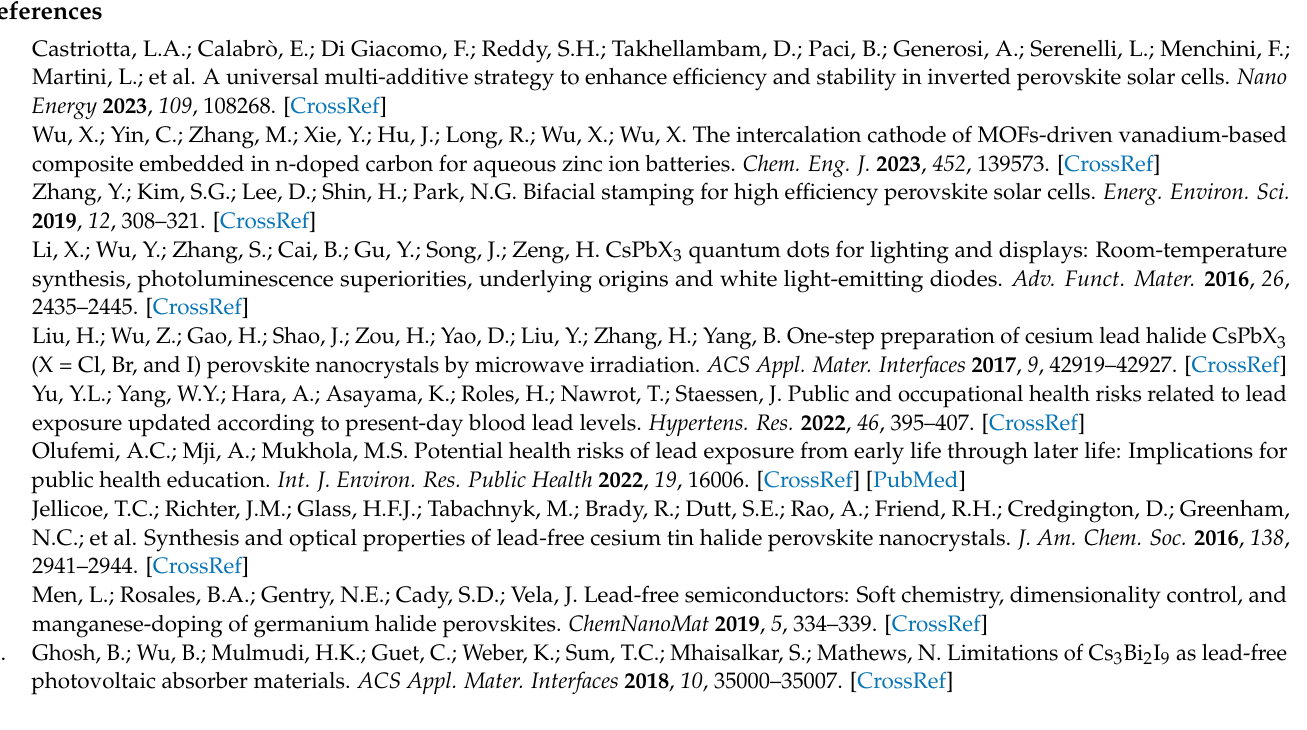
Figure S2: Enlarged shifts of (220) peak of MCs; Figure S3: XPS spectra of MCs; Figure S4: Rep- resentative XPS spectra of Sn 3d in the MCs; Figure S5: PLE spectra of MCs in the visible region; Figure S6: PL spectra of MCs in the NIR region; Figure S7: PL emission spectra of MCs in the NIR region; Figure S8: PL emission spectra of x % Te 4+ -10% Er 3+ co-doped MCs; Figure S9: NIR inten- sity variations of MCs with different Er 3+ concentrations; Figure S10: Fitting results of the FWHM; Figure S11: Integral intensity of NIR peak at different temperatures ; Figure S12: Peak intensity ratio of 1540 nm (I 1540 )/1562 nm (I 1562 ) emissions at different temperatures; Figure S13: XRD patterns of MCs before and after their exposure to ambient air; Figure S14: PL emission spectra of MCs before and after their exposure to ambient air; Figure S15: PL emission spectra of MCs before and after their soak in water; Figure S16: XRD patterns of MCs before and after their soak in water; Table S1: Elemental analyses of the MCs by EDS; Table S2: Results of the Te and Er ion ICP-MS test in MCs; Table S3: The calculated lattice parameters of MCs via XRD peaks; Table S4: Average PL lifetimes of MCs with different Er 3+ concentrations; Table S5: Temperature-dependent PL lifetimes of